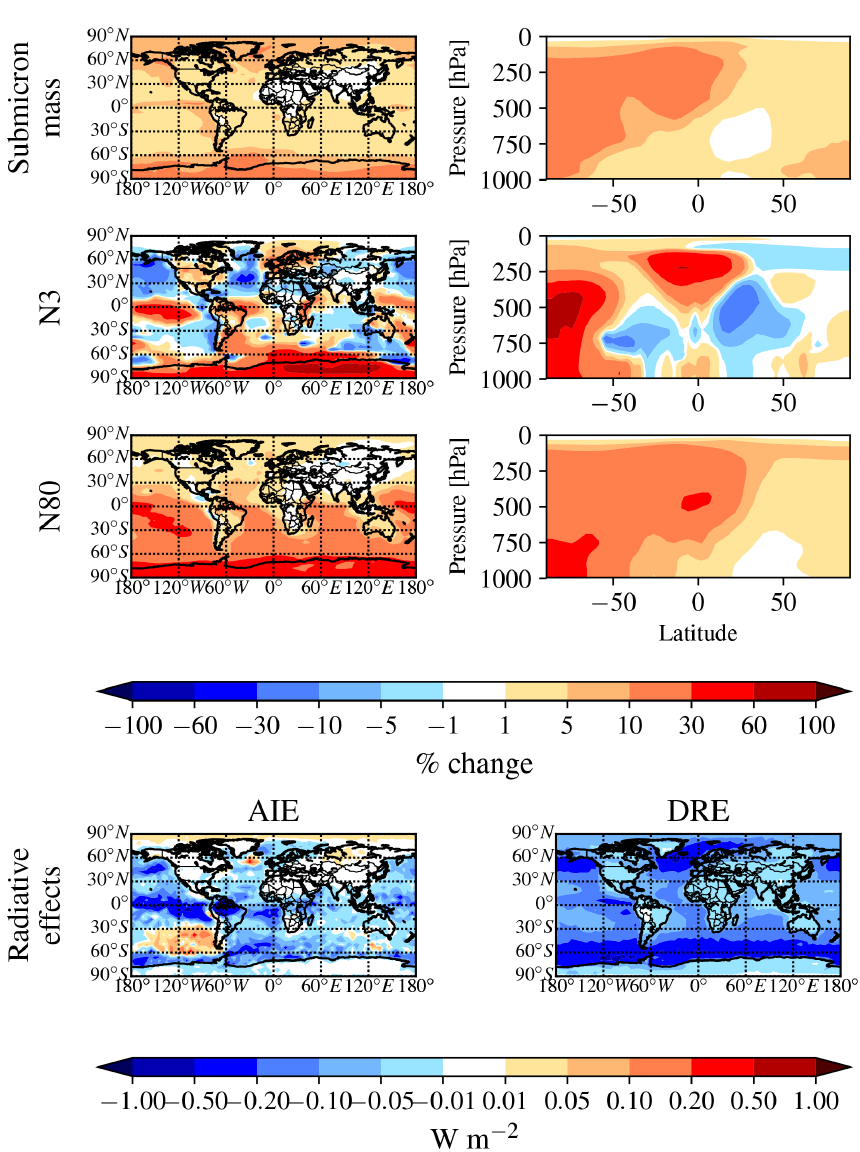
Figure 5. Global annual mean changes between the NoDMS_NoMSA and DEFAULT_NoMSA simulations. First row: percent change in submicron aerosol mass at 900hPa (left) and zonally (right). Second row: percent change in N3 at 900hPa (left) and zonally (right). Third row: percent change in N80 at 900hPa (left) and zonally (right). Fourth row: change in Wm − 2 in the radiative effects. This figure gives the contribution from sulfate and sulfuric acid produced from DMS / SO 2 oxidation to the aerosol mass, number, and radiative effects. Warm colors indicate that sulfate and sulfuric acid produced from DMS / SO 2 oxidation increase the